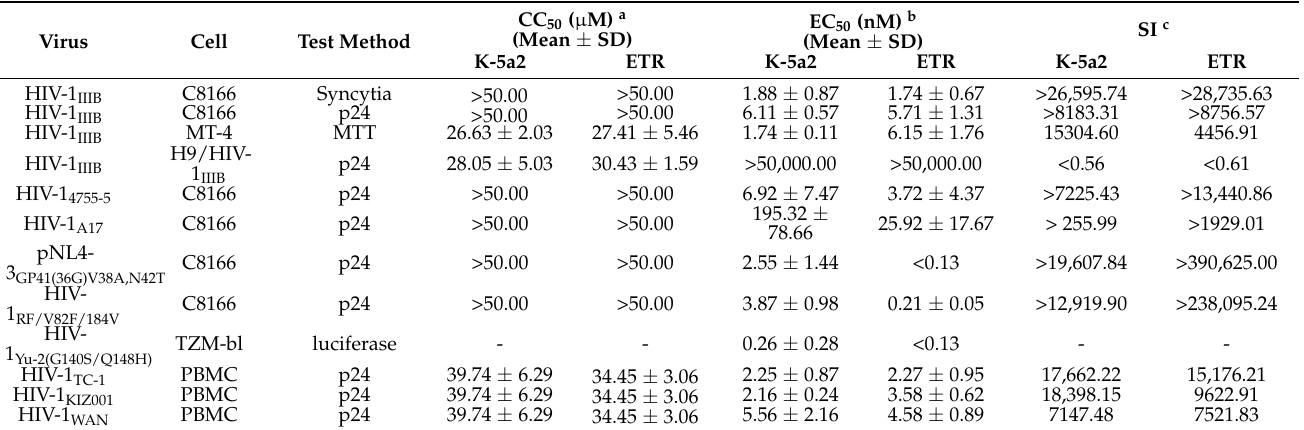
Table 1. Summary of anti-HIV-1 activities of K-5a2 and ETR in cell